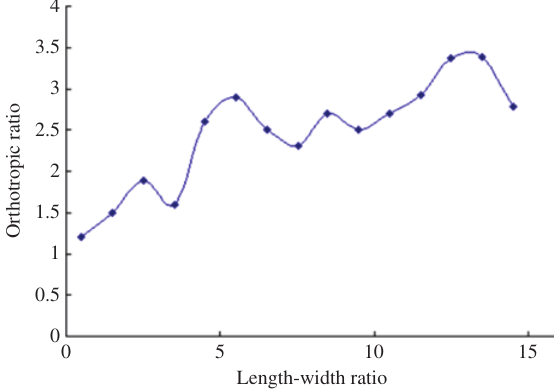
Figure 10: The relationship between the aspect ratio and the orthotropic ratio.